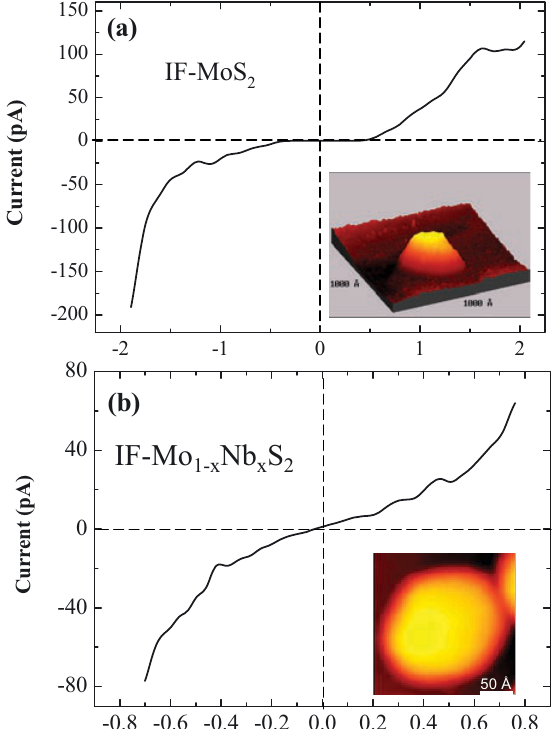
Figure 14. I-V curves at room temperature measured on (a) an IF-